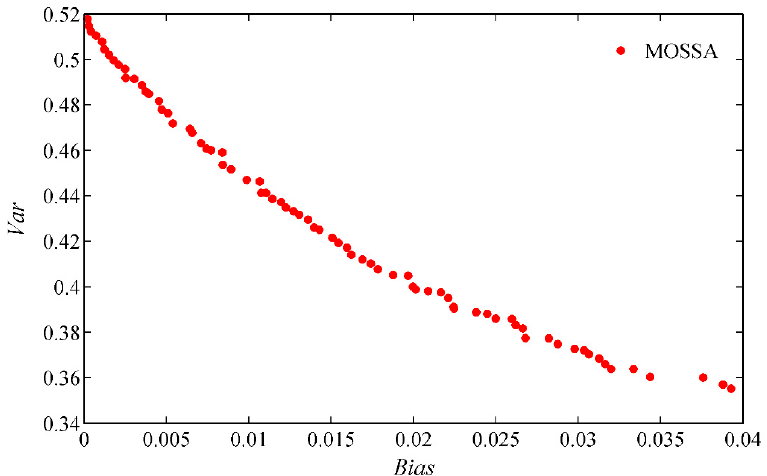
Figure 7. The best solution selection from Pareto ‐ optimal sets of MOSSA.